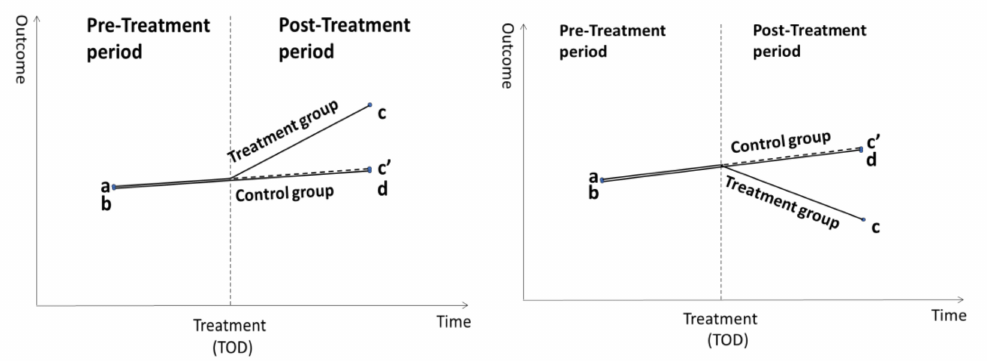
Figure 2. DiD design and randomness without pre-treatment